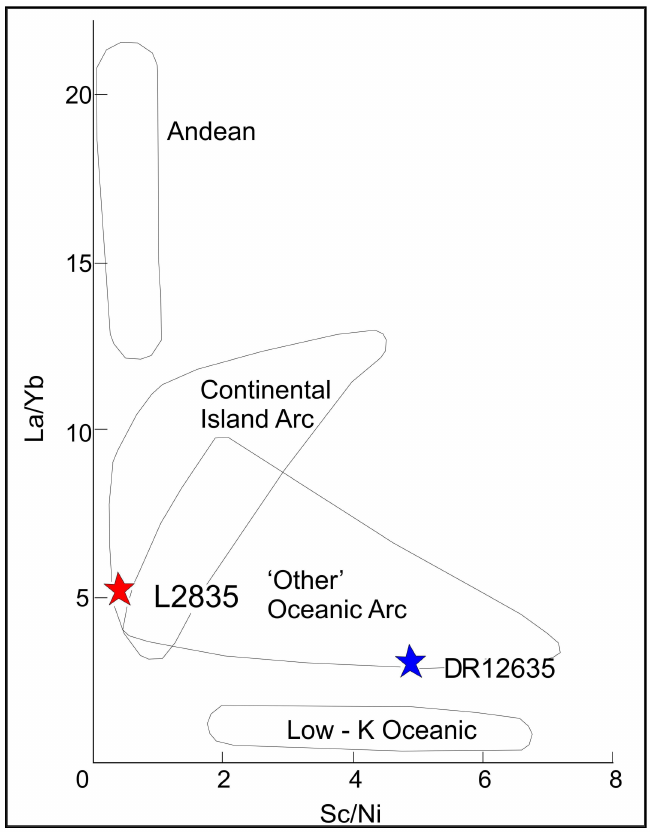
Figure 4. La/Yb vs. Sc/Ni diagram modified after [27].